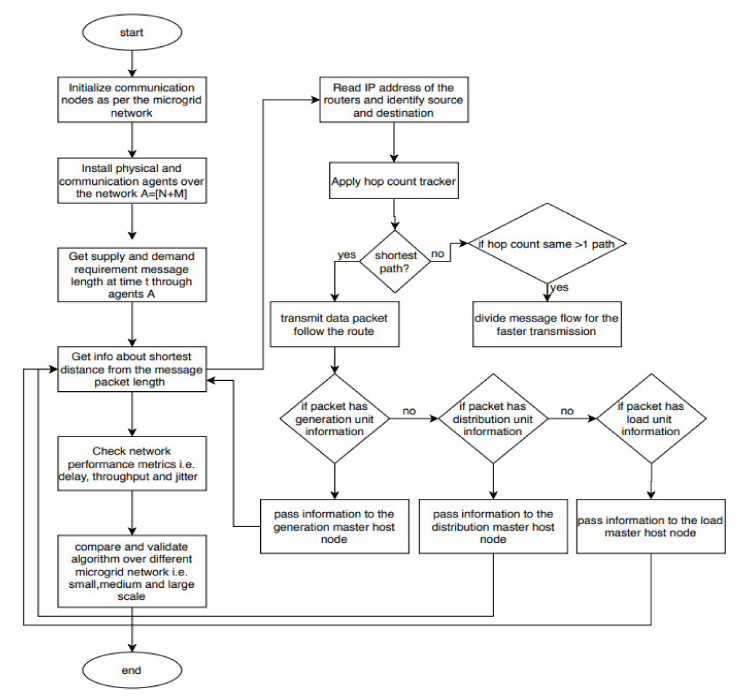
Figure 6. Flow chart for the proposed